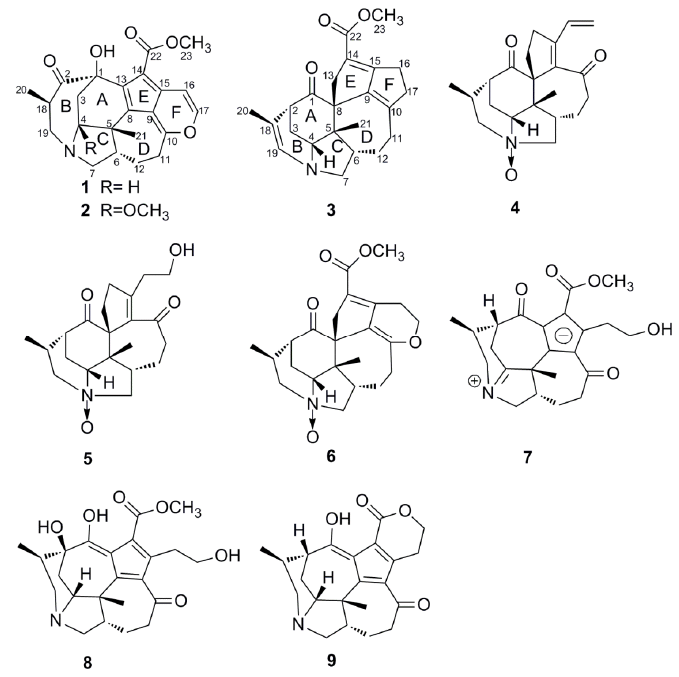
Figure 1. Structures of compounds 1 – 9